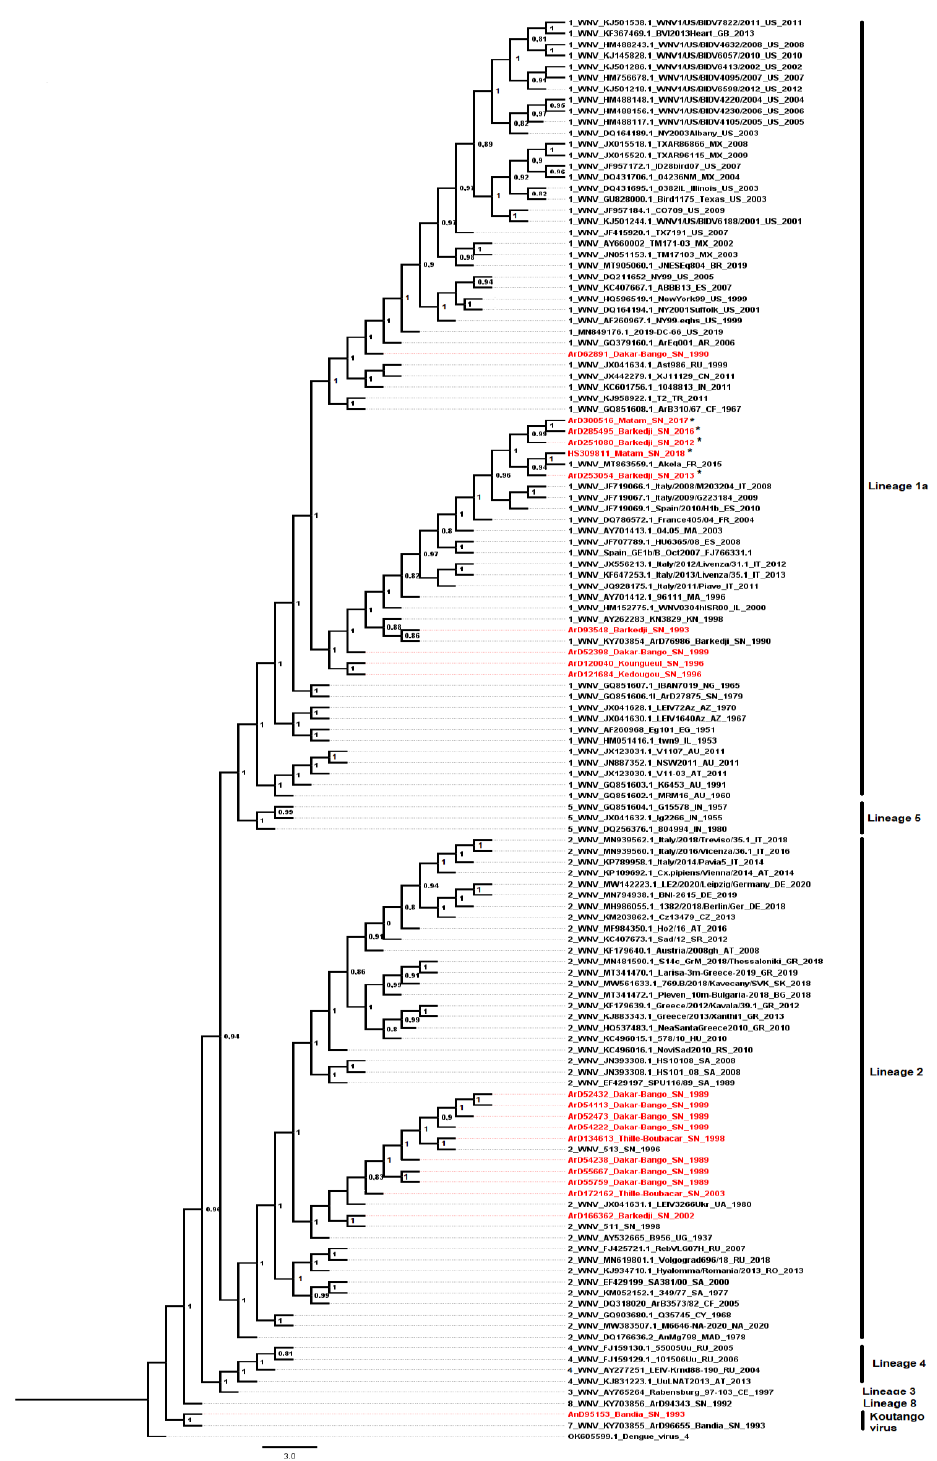
Figure 5. Maximum Likelihood (ML) tree based on complete polyprotein sequences of West Nile virus isolates circulating in Senegal from 1989 to 2018. The tree is midpoint-rooted, nodes are labeled with local support values computed using the Shimodaira-Hasegawa (SH) test for 5000 bootstrap replications. The new characterized WNV isolates from Senegal are color-coded in red in this tree. The most recent strains isolated from a human in 2018 (HS309811_Matam_SN_2018*) and from mosquito pools collected in 2017 (ArD300516_Matam_SN_2017*), 2016 (ArD285495_Barkedji_SN_2016*), 2013 (ArD253054_Barkedji_SN_2013*), 2012 (ArD251080_Barkedji_SN_2012*), respectively, are pointed with the asterisk sign (*). These recent characterized Senegalese WNV isolates are belonging to the lineage